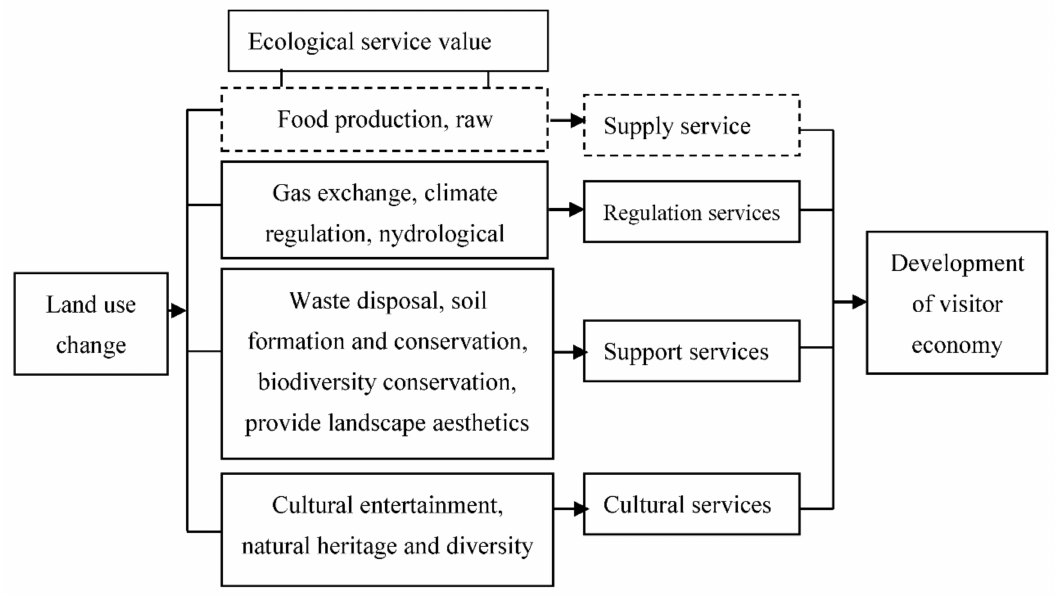
Figure 5. Mechanism of land use promoting tourism economic